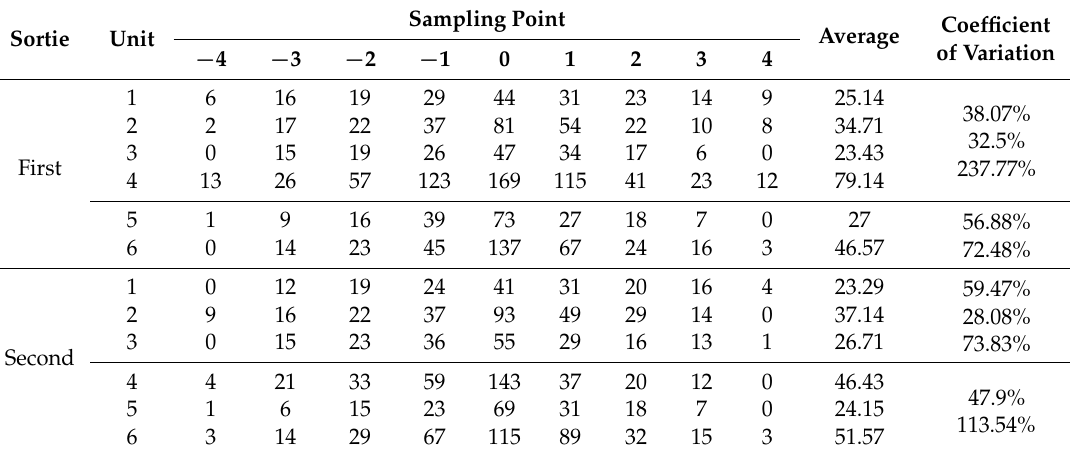
Figure 19. Grayscale image of water-sensitive paper. Table 4. Statistics of droplet coverage density.